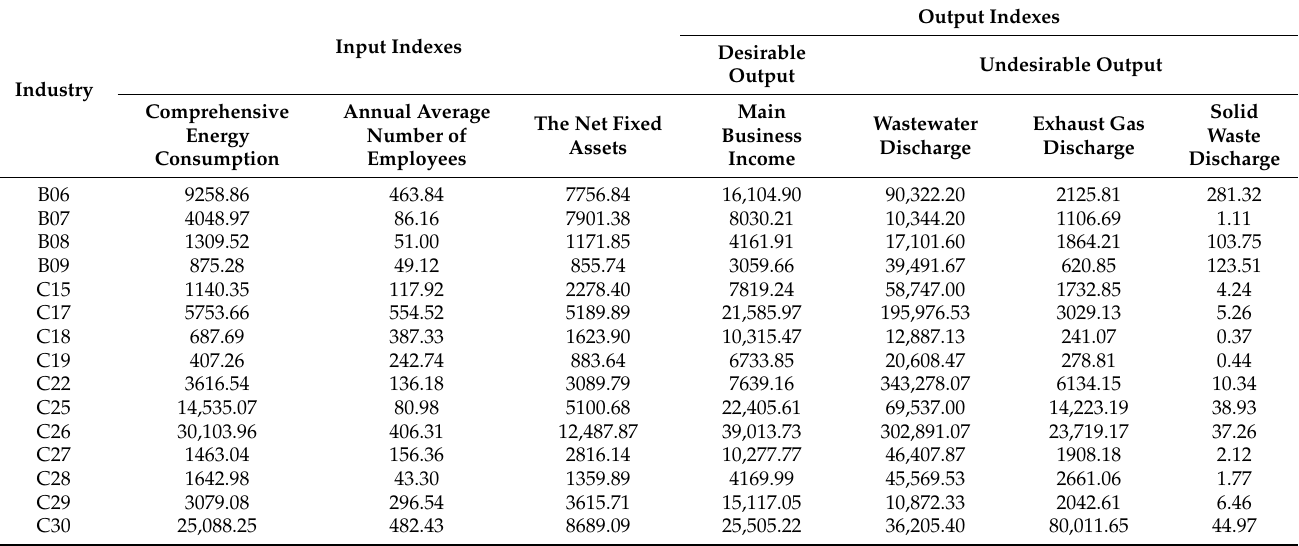
Table 2. The main data of the indicators of 19 high-pollution